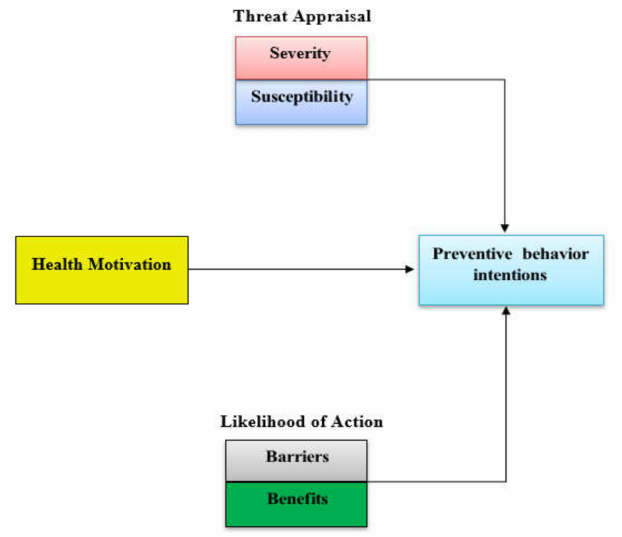
Figure 3. HBM model (Figure adapted from Lipman & Burt (2017)) (adapted from